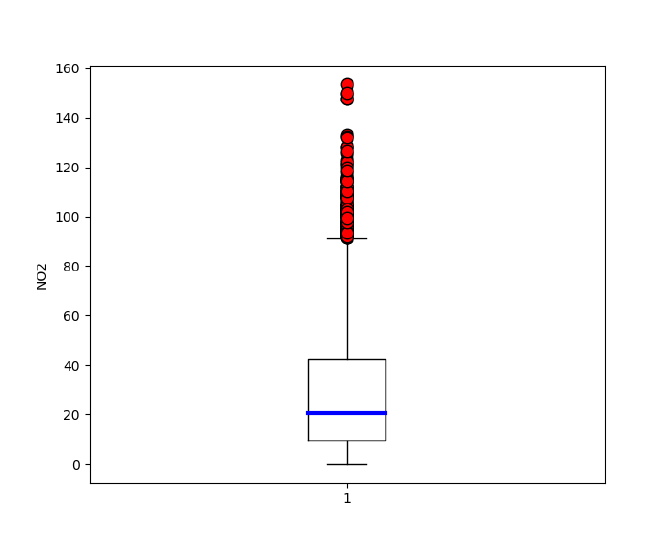
Figure 2. Box-plot of hourly NO 2 concentrations from Blanchardstown air quality monitoring station. The central and blue line represents the median, and the end of the whiskers are the quartiles (25% for the lower part and 75% for the upper part). The red dots represent the outliers. Software: Python